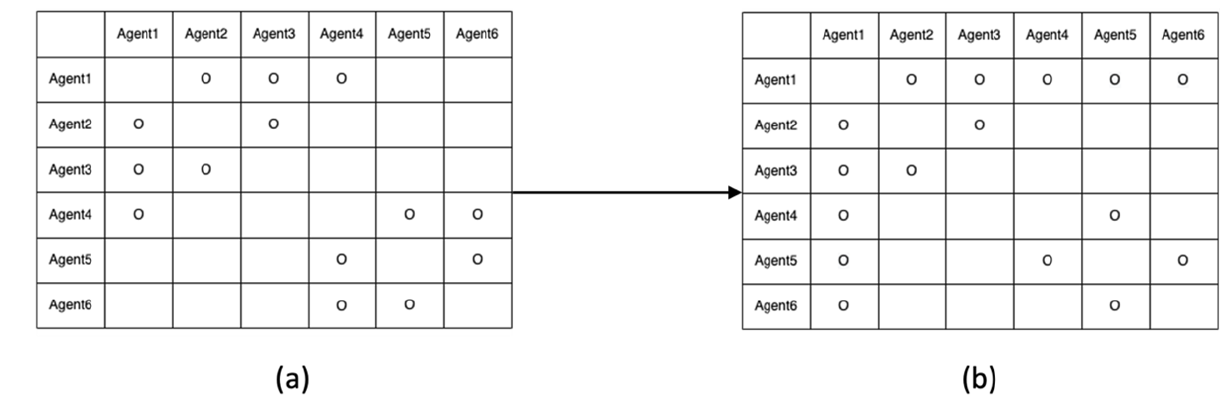
Figure 11. ART table after implementing antenna array-aided RTK with agents 1, 4, and 5. ( a ) Mod- ified ART after the one-to-one RTK between the two master agents. ( b ) Further modified ART by updating N 15 and N 16 .